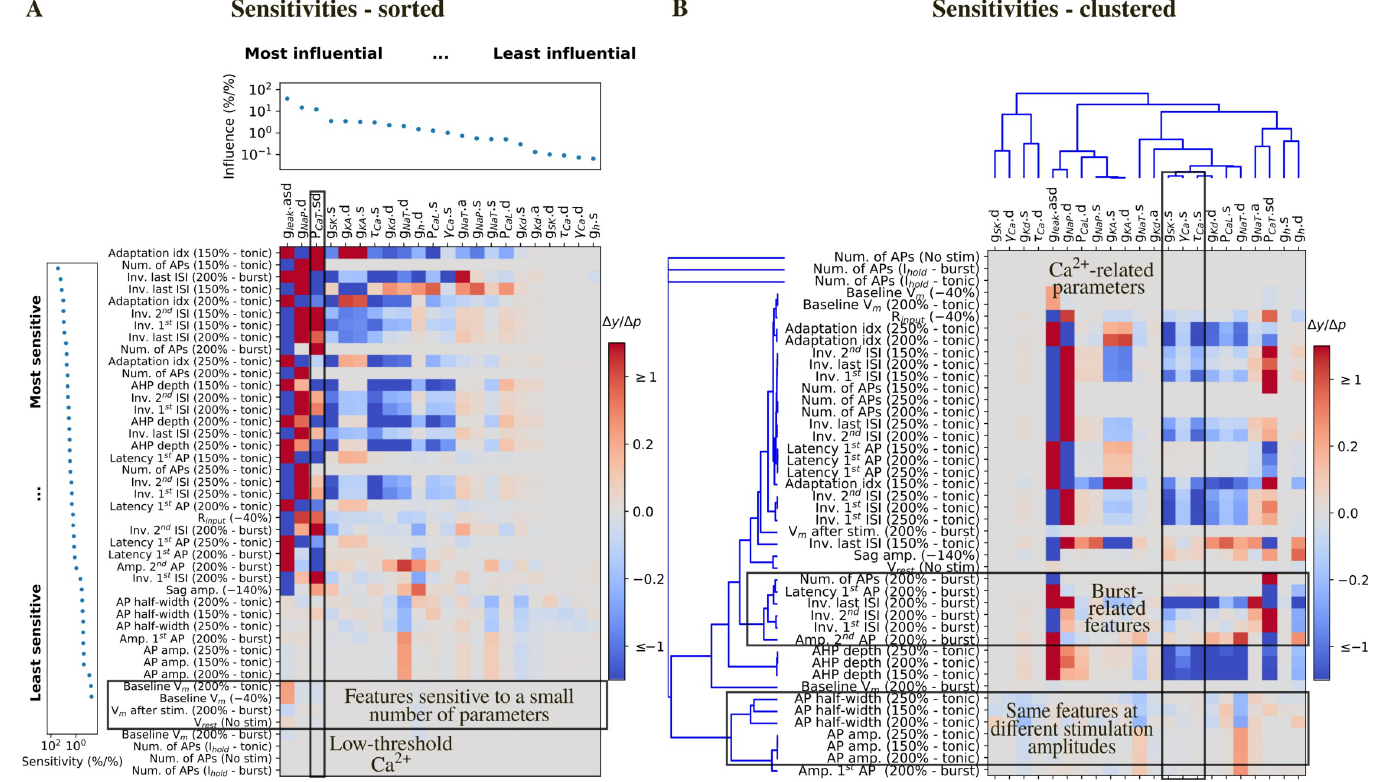
Fig 7. Local sensitivity analysis. (A) Sensitivity of the feature values to small changes to the parameter values for the cNAD_ltb model in Fig 4. Sensitivities ( Δ y/ Δ p)are color coded as a heat map. Features are ranked from the most to the least sensitive and parameters are ranked from the most to the least influential. The last three rows are features that ensure that the models were not firing without input or in the response to the holding current. Small changes to the parameter values are not expected to make the model firing and thus the sensitivity of these features is 0. (B) Same sensitivity values as in (A), with features and parameters clustered by similar sensitivity and